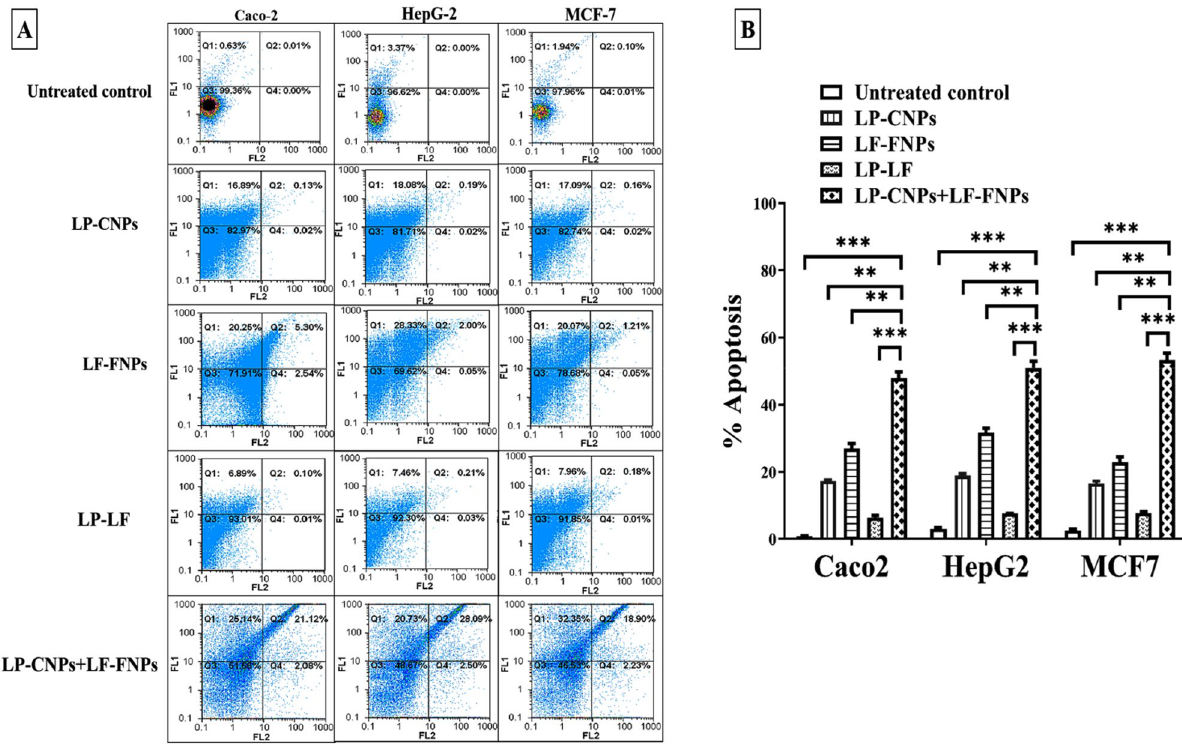
Figure 3. Flow cytometric analysis of apoptotic effect of the most effective anticancer nanoformulas and LP + LF. ( A ) Flow charts of LP-CNPs, LF-FNPs, LF-LP and LP-FNPs + LF-FNPs-treated Caco2, HepG2 and MCF7 cells relative to the untreated cells with ( B ) the percentage of total apoptotic cell population [% of both early and late apoptosis stages (annexin V-stained population “Q1” and annexin V/PI-stained population “Q2”, respectively)]. All values are demonstrated as mean ± S.E. LP-CNPs + LF-FNPs were compared to other formulas and considered statistically significant at p < 0.05*, p < 0.005**, p < 0.0005***. CNPs: CuO nanoparticles;